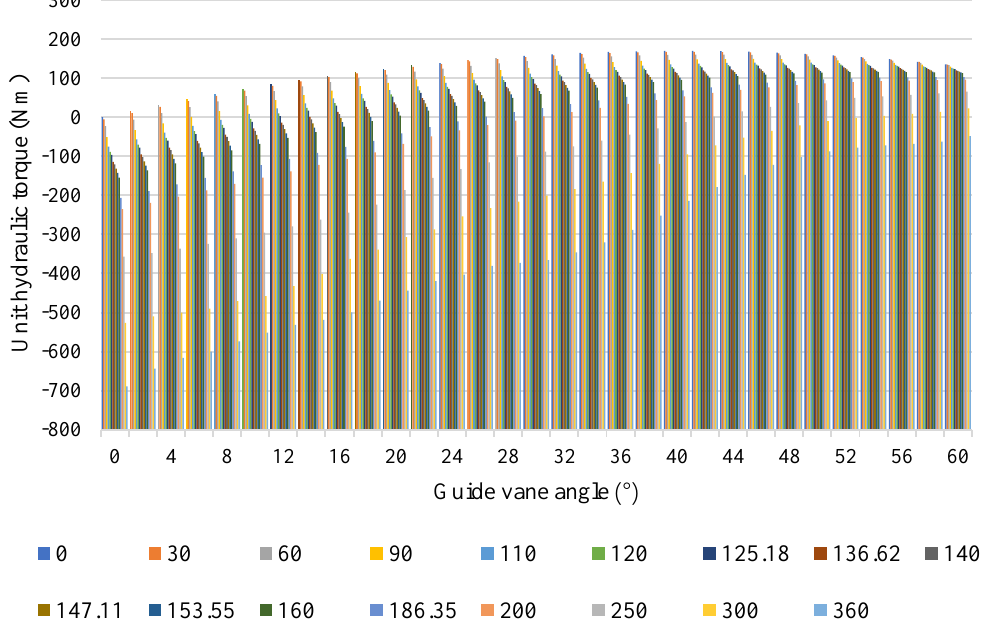
Figure 11. The relationship among the unit hydraulic torque, the guide vane opening, and the unit rotation speed when the blade angle is 14 degrees.